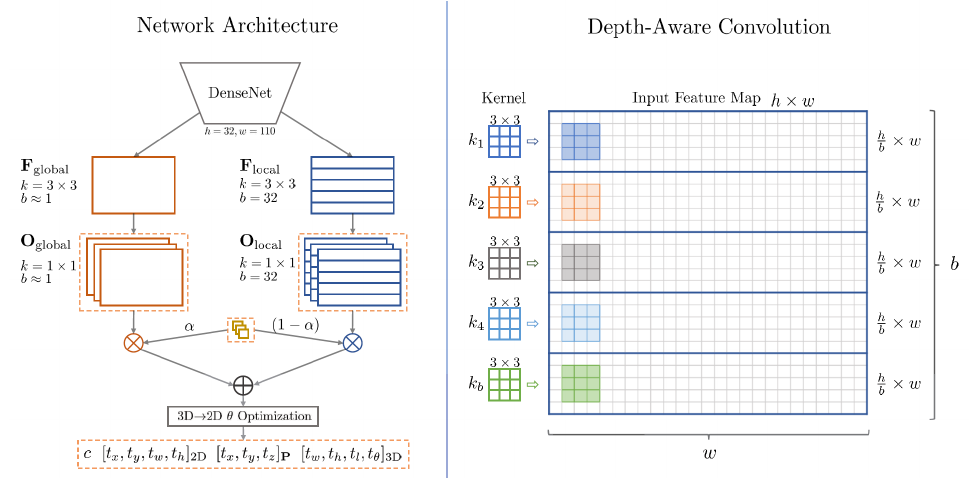
Figure 9. Overview of M3D-RPN [26]. It consists of parallel paths for global and local feature